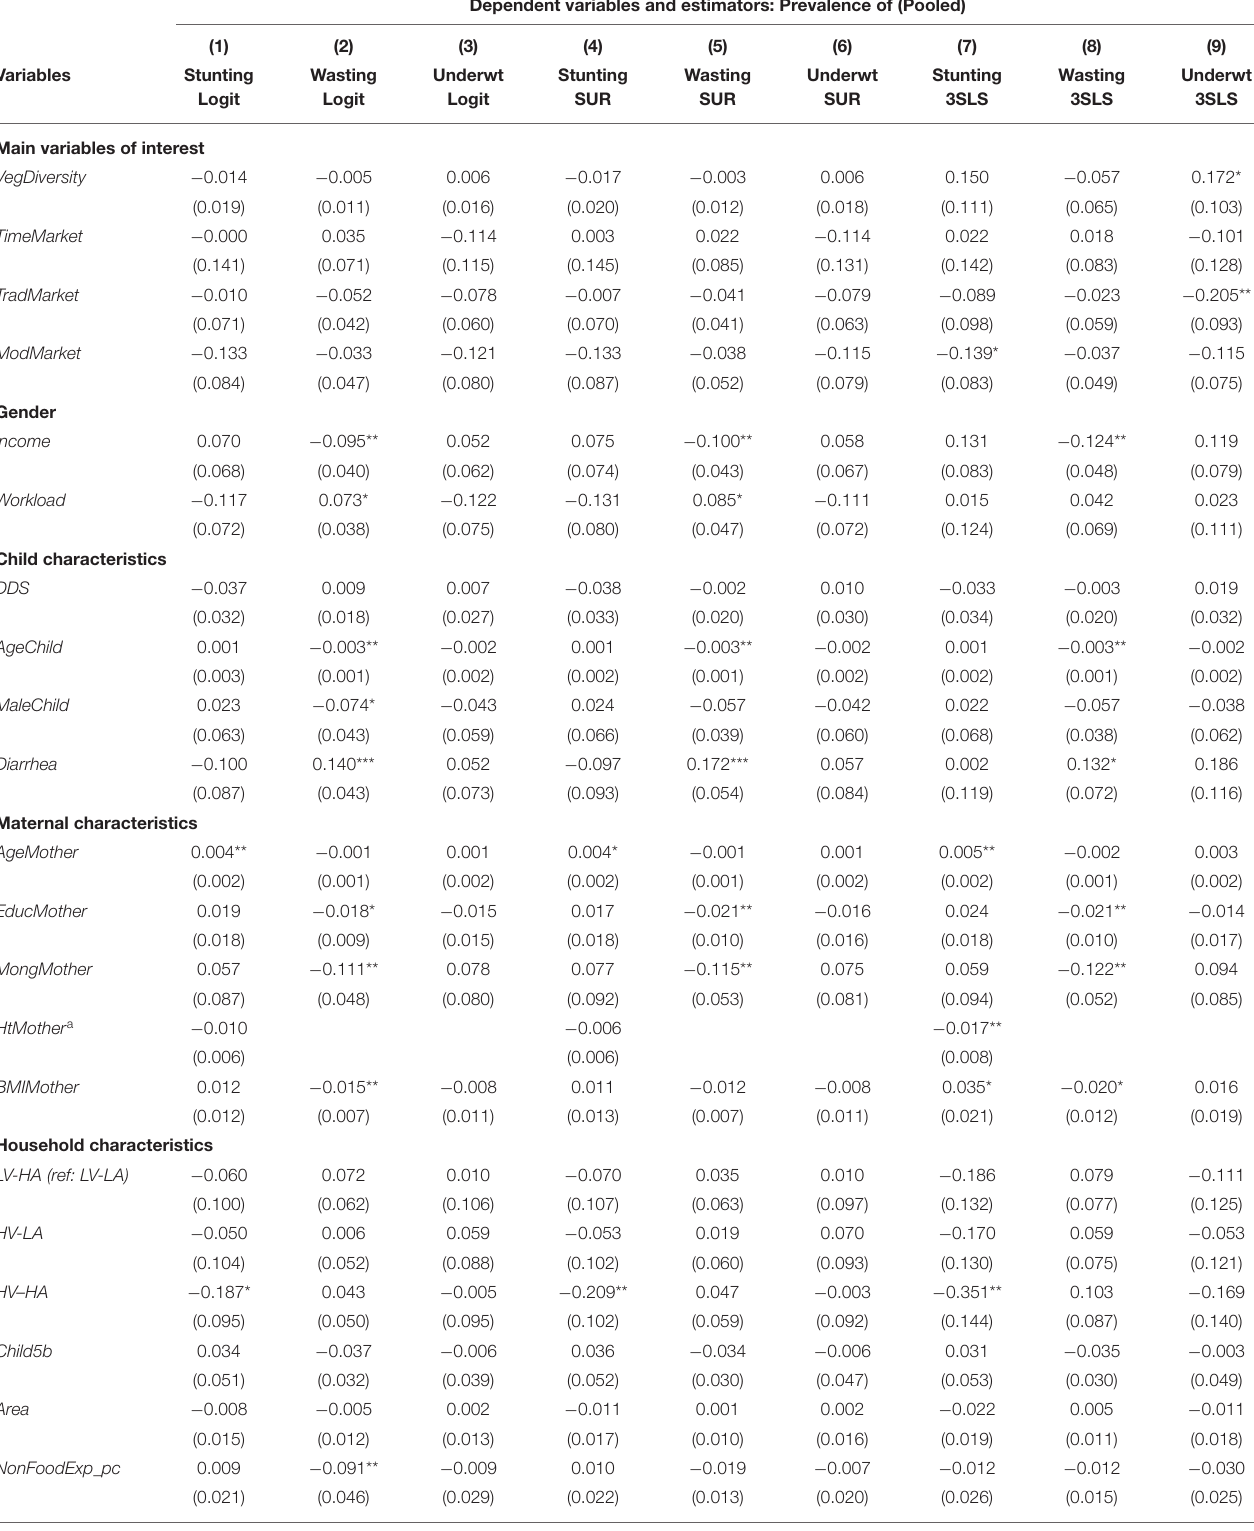
TABLE 4 | Impact of smallholder vegetable production on the prevalence of stunting, wasting, and underweight of pooled sample. Dependent variables and estimators: Prevalence of